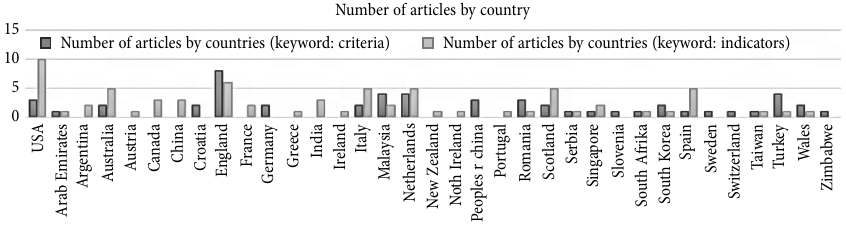
Fig. 3. Review of articles on criteria and indicators of the sustainable built environment by country